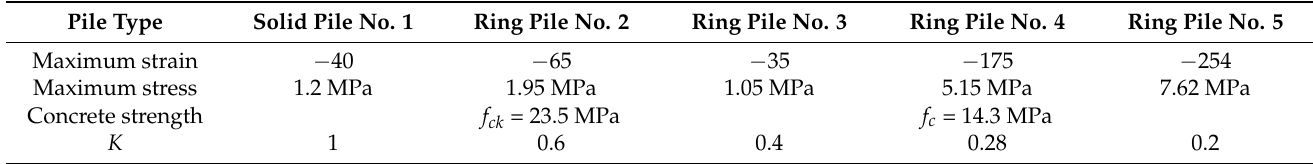
Table 7. Stresses corresponding to the peak strain of the piles.